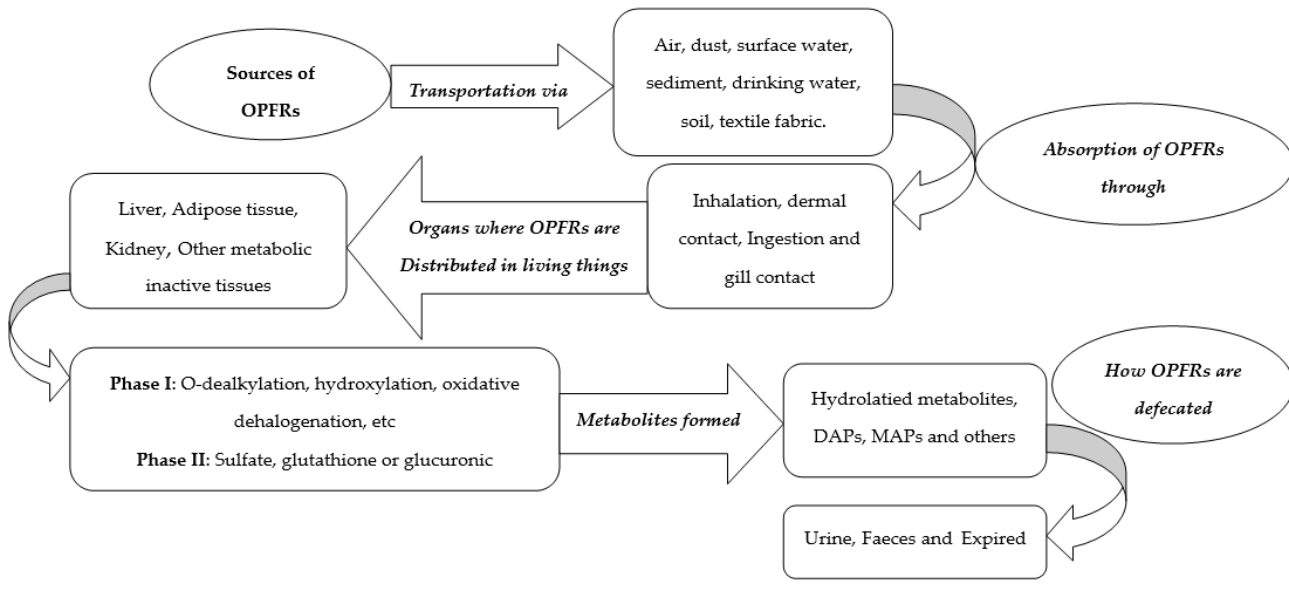
Figure 2. A diagram showing providence of OPFRs in animal and human bodies [33].